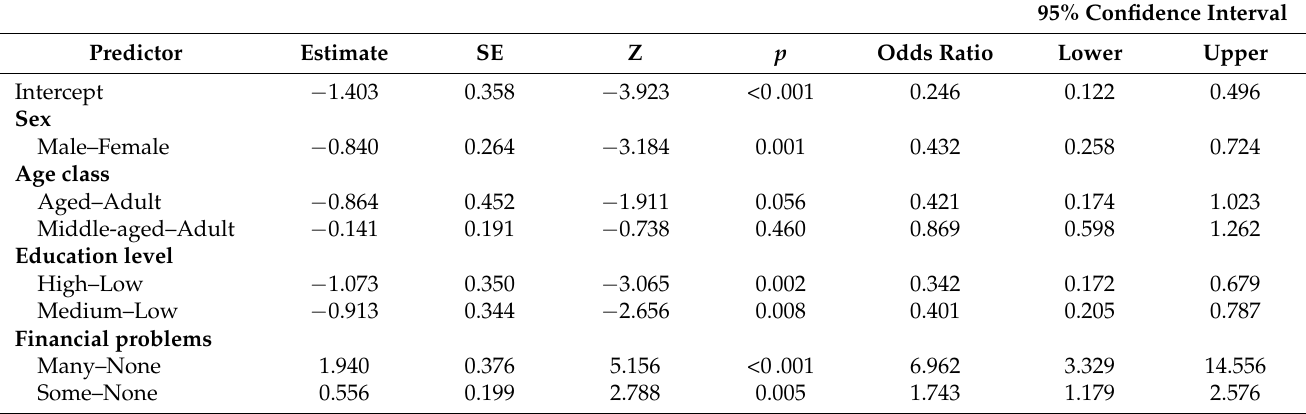
Table A1. Results of Multivariate Regression Analysis Models, with Quality of Sleep as Dependent Variable and Financial Problems and Sociodemographic Characteristics as Independent Variables.